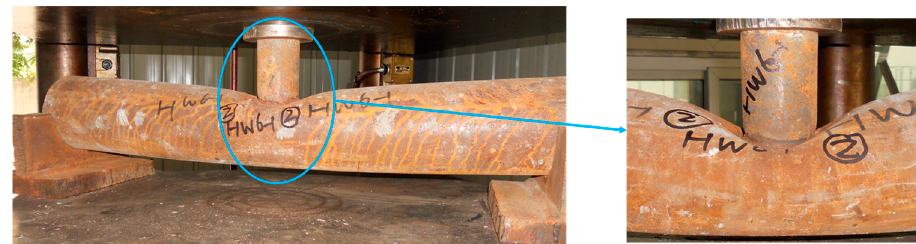
Figure 6. Typical flexural failure mode of UHSCFST specimen.